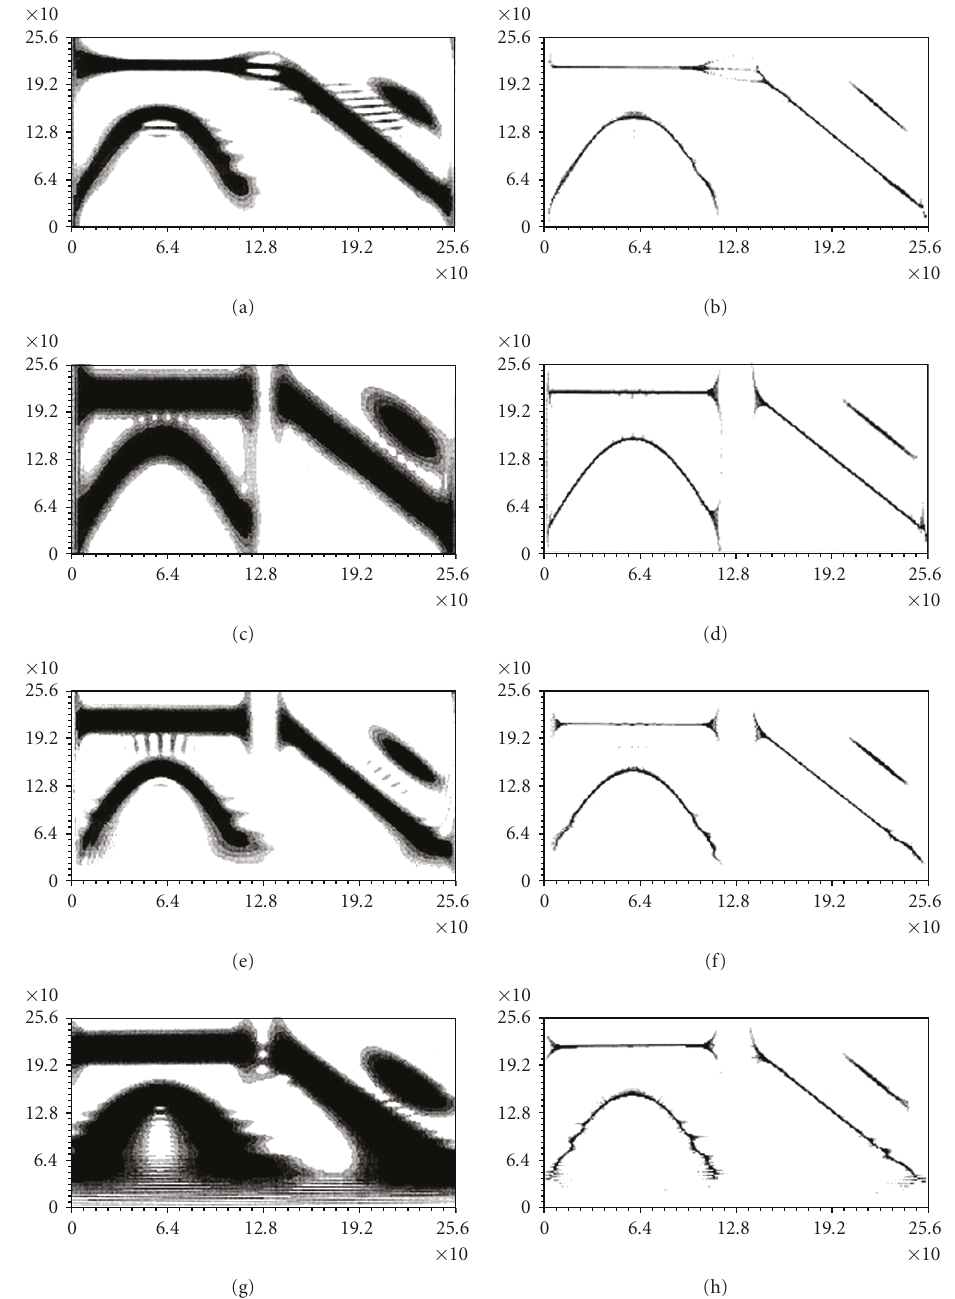
Figure 9: Numerical examples for reassignment method for a 4-component signal made up of a sine wave component, a chirp component, a chirped Gaussian packet, and one signal with constant amplitude and an IF describing half a sine period, (a) SPWD. h : 79-point Gaussian window, (b) modified version of the SPWD, (c) spectrogram. h : 31-point Gaussian window, (d) modified version of the spectrogram, (e) a ffi ne SPWD. h : Gaussian window with F 0 · Th = 4 . 24, (f) modified version of a ffi ne SPWD, (f) scalogram. h : Gaussian window